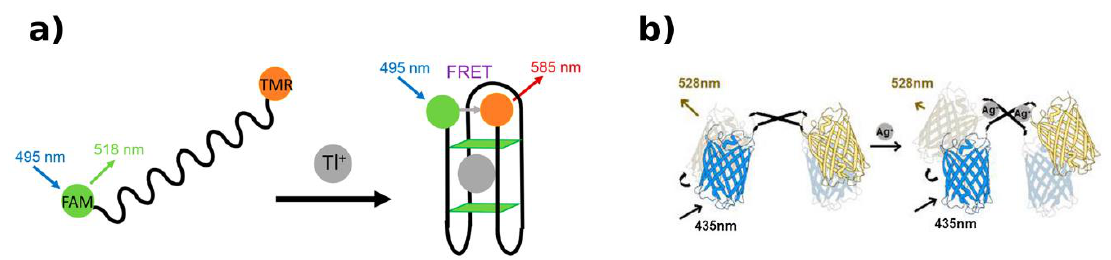
Figure 9. FNAs and protein constructs for FRET-based HM detection. ( a ) The Tl + causes the G4 structure formation, leading to a shortening of the distance between the donor and acceptor, thus inducing an enhancement in FRET efficiency [88]. ( b ) The decrease in FRET efficiency is induced by conformational change of the CupR protein, in the presence of Ag + [121]. Adapted with permission of the Publishers.